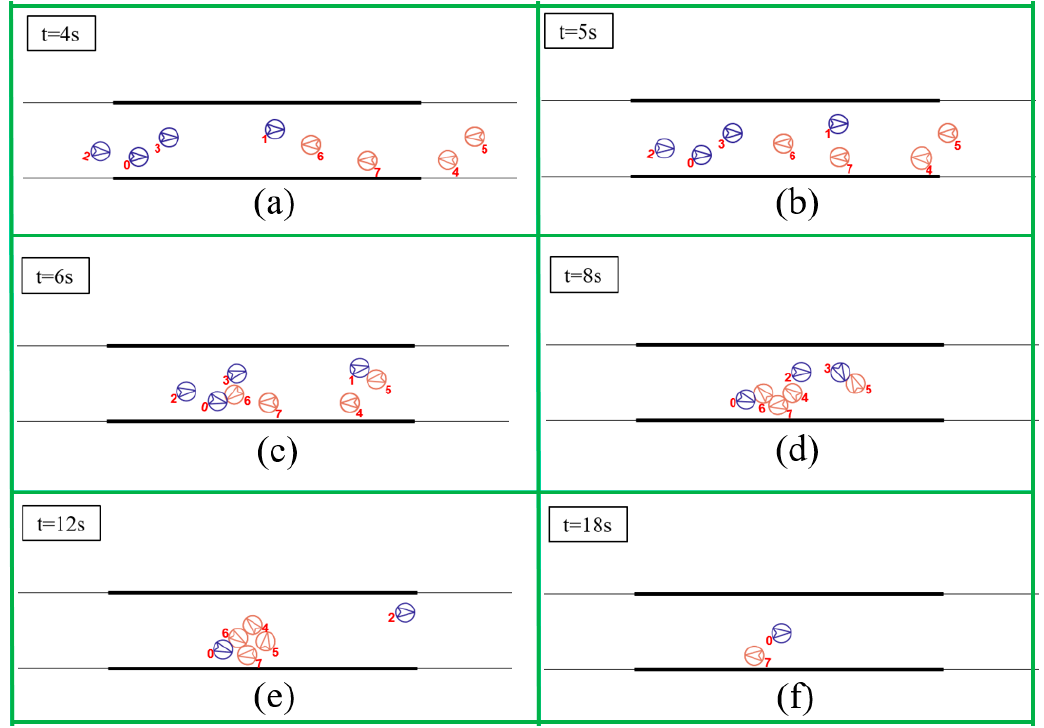
Figure 17. Screenshot of the simulation of human motion in the opposite direction.